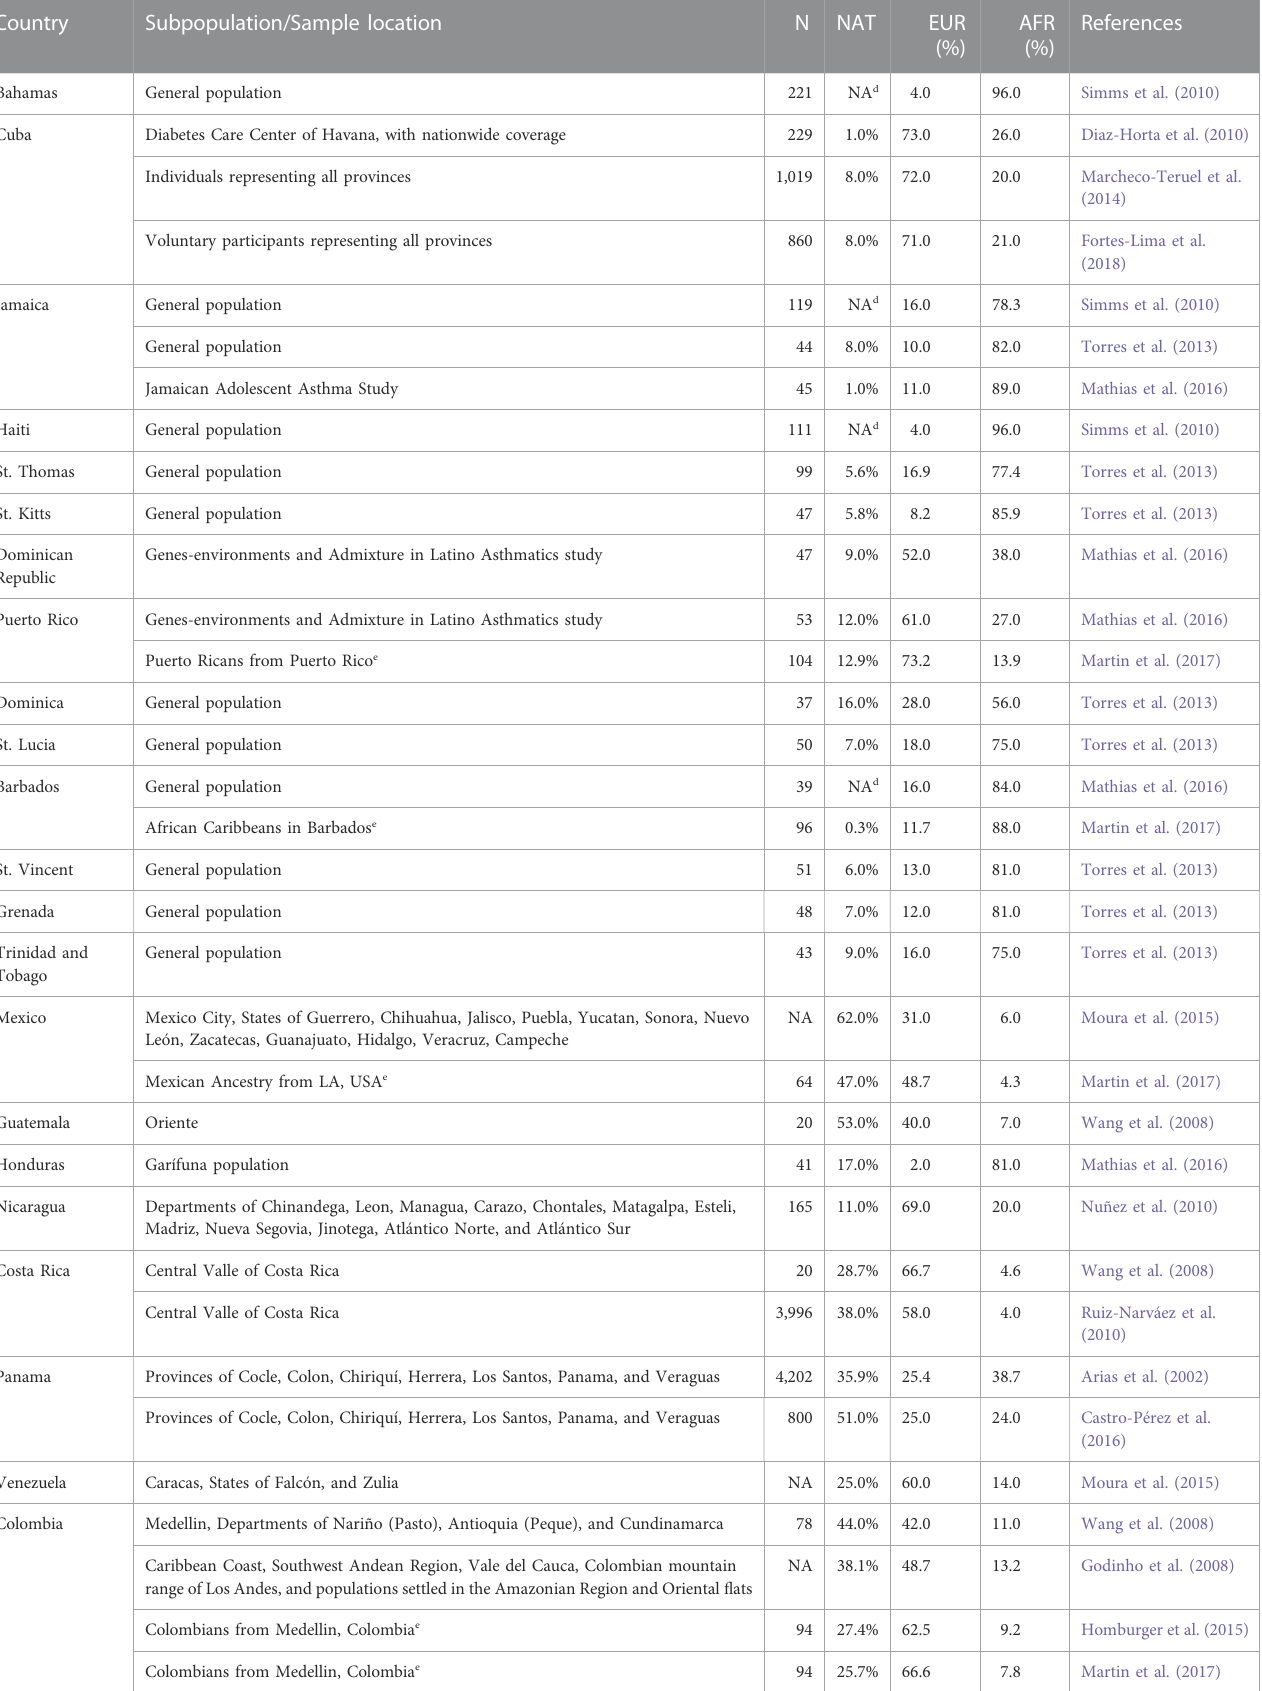
TABLE 1 Global ancestry proportions among Latin America and the Caribbean countries.